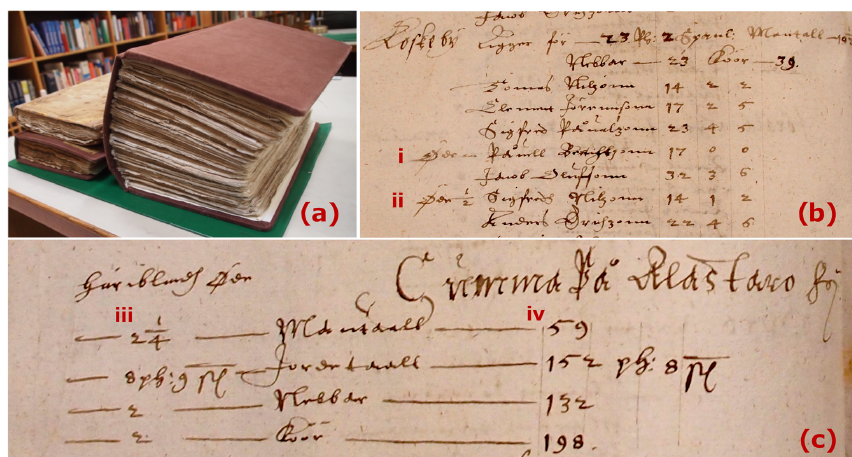
Figure 2. (a) Early 17th century annual land, account, and verification books (from bottom left to right). (b) Examples of two deserted farmsteads in the 1603 land book, which also documented the numbers of adults living in the holding (second column from the right). The first holding (i) was uninhabited, whereas the second holding (ii) still had one adult living on the farmstead. (c) Example of the registers from which the desertion data for this study are gathered: the chapel of Alastaro (Vähäkyrö) held 59 mantal farmsteads (iv), of which 2.25 mantal units were deserted